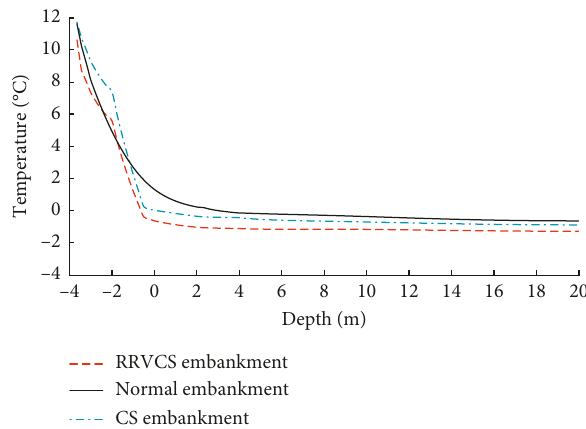
Figure 11: Temperature variations with depth at centerline of